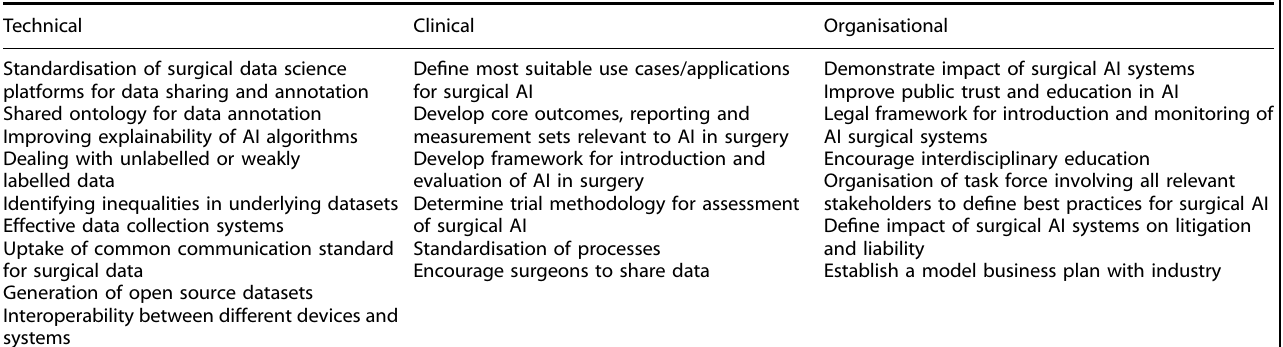
Table 3. Future research goals for digital surgery identi fi ed and ranked highest to lowest in order of importance by the Delphi panel. Technical